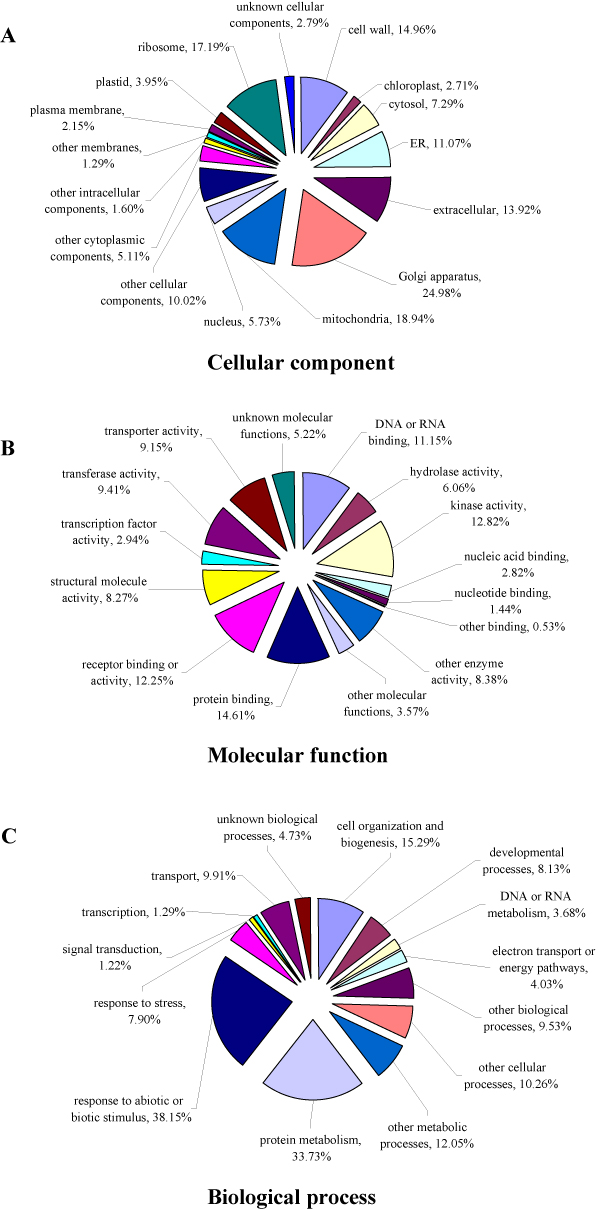
GO analysis of P. notoginseng unique sequences based on cellular component (Figure 3A), molecular function (Figure 3B), and biological process (Figure 3C).